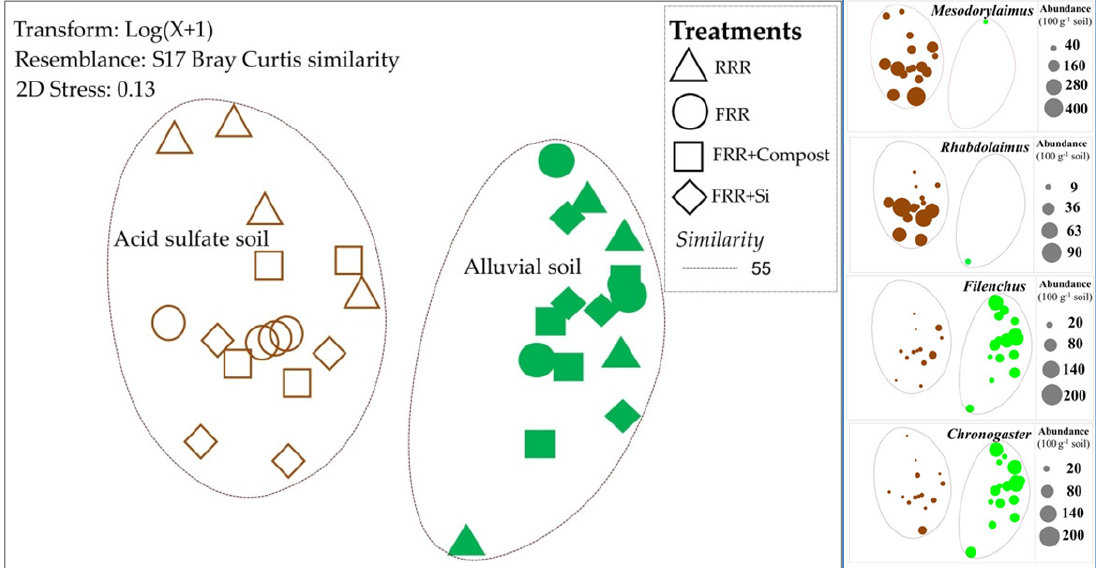
Figure 1. Non–metric dimension scale (nMDS) analysis of entire nematode composition among two different soil types, the acid sulfate soil in Ben Tre province and the alluvial soil in Kien Giang province, Vietnam. This study was a part in our previous study [17]. Circle lines indicate the similarity of nematode composition within a soil type by nMDS analysis, representing a 55% similarity. The distribution patterns of dominant genera have also been demonstrated by nMDS analysis, indicating the most common genera (excluding Hirschmanniella ) in different soil types (the size of the circle indicates the abundance 100 g –1 dry soil). Mesodorylaimus and Rhabdolaimus (brown circle) are present in acid sulfate soil and Filenchus and Chronogaster (green circles) are present in alluvial soil.